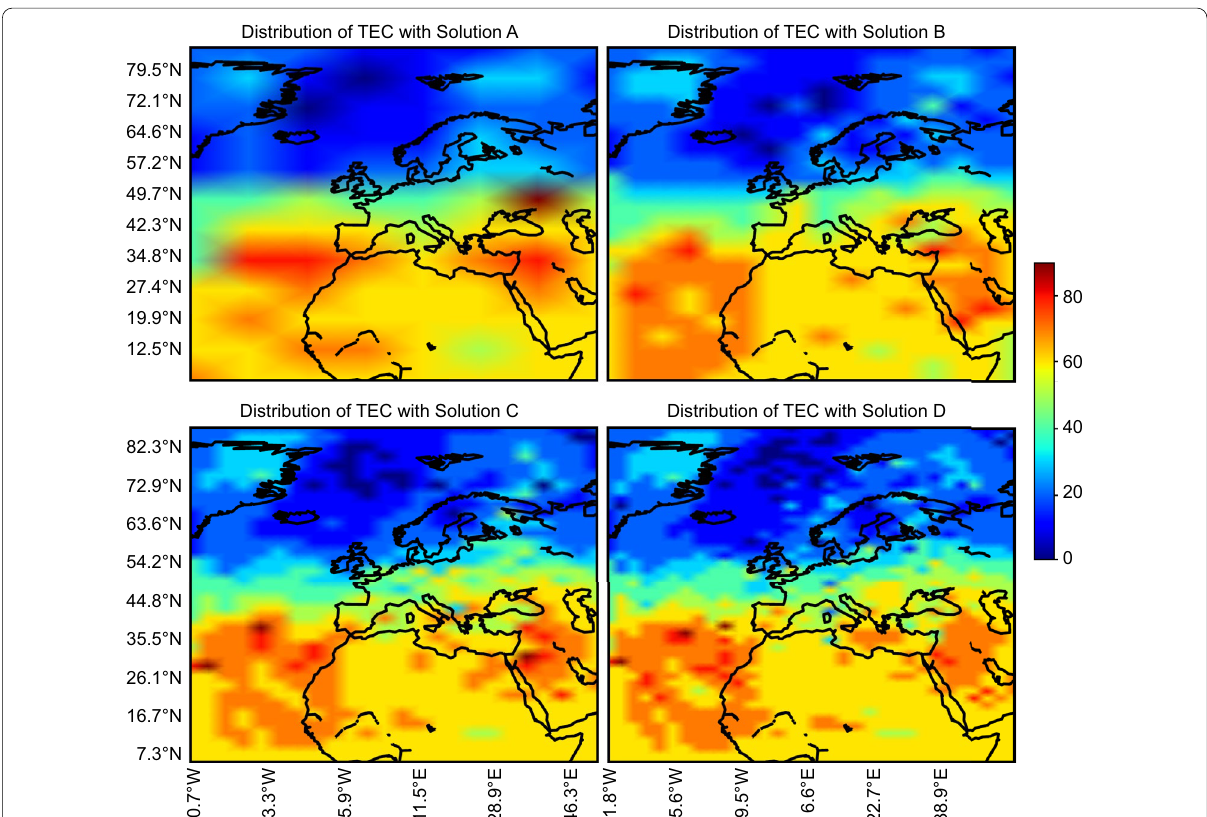
Fig. 3 Distribution of the 2‑dimensional TEC map with the resolution of 12 × 8 , 24 × 16 , 36 × 24 , and 48 × 32 in latitude and longitude for